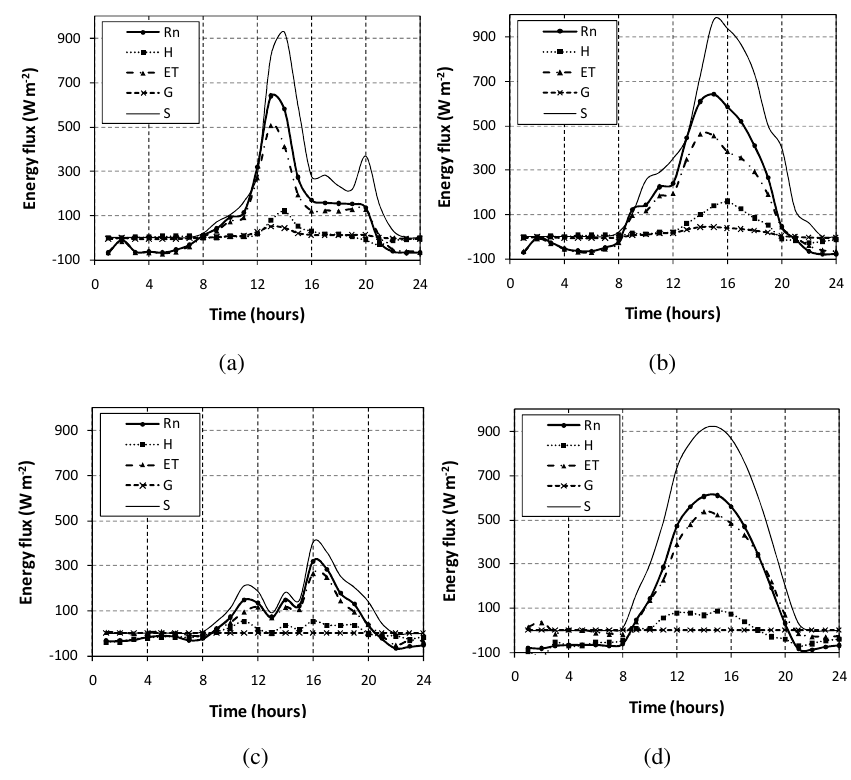
Fig. 4. Diurnal evolution of the sorghum flux components of the energy balance equation, together with the solar global radiation: (a) DOY 184, (b) DOY 185, (c) DOY 229, (d) DOY 236.